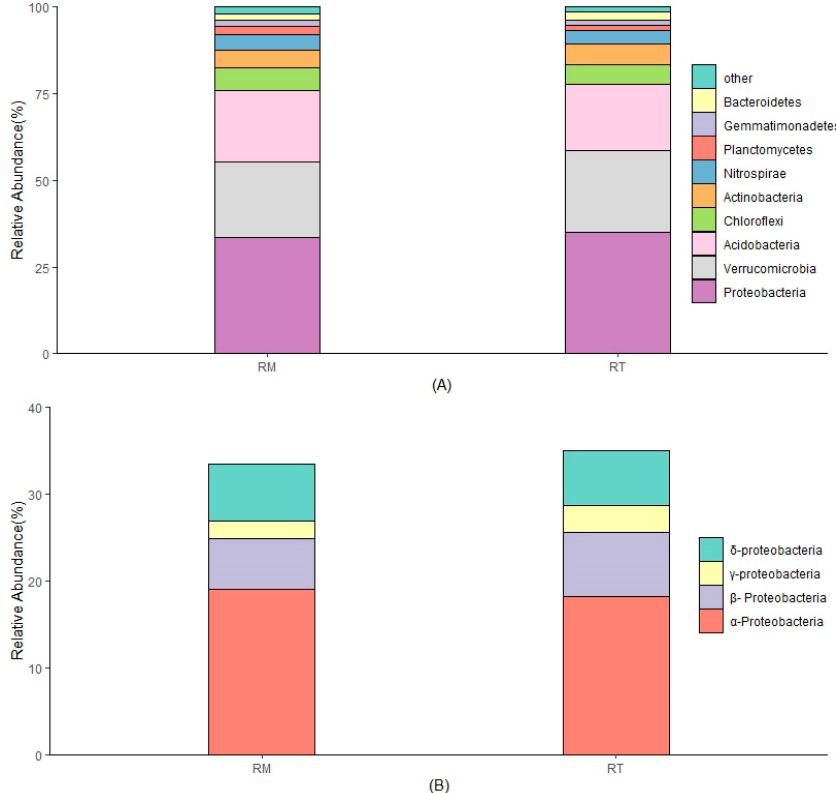
Figure 3. The relative abundance of soil bacterial communities at the phylum level ( A ), and class composition of Proteobacteria ( B ). RT: residue retention; RM: residue removal. Burkholderiales and Pseudomonadales belong to β -Proteobacteria , and γ -Proteobacteria ,